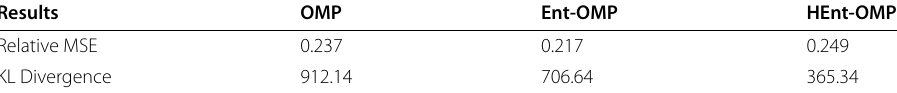
Table 1 Comparison of relative MSE and KL (Kullback-Leibler) divergence for the toy model Results OMP Ent-OMP HEnt-OMP Relative MSE 0.237 0.217 0.249 KL Divergence 912.14 706.64